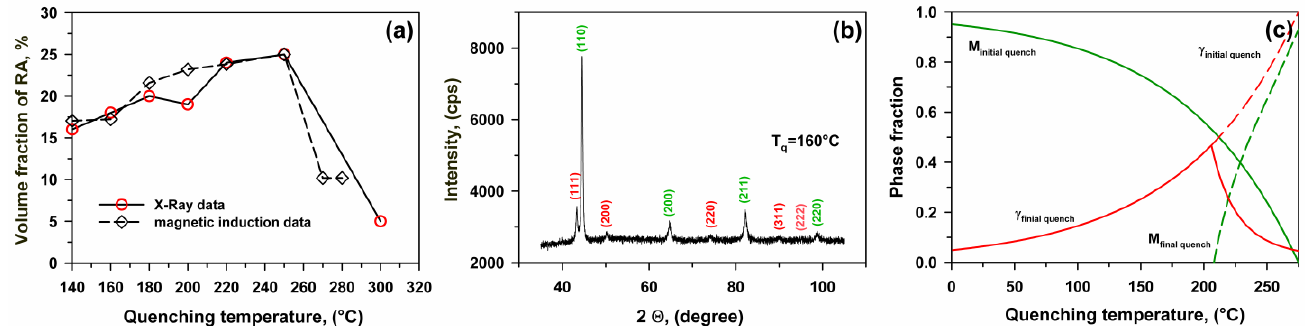
Figure 8. Effect of quenching temperature on the volume fraction of RA ( a ); typical XRD spectra after quenching at 160 ◦ C ( b ); calculated T q -dependence of the phase fraction of austenite and secondary martensite, assuming full C partitioning into austenite prior to the final quenching ( c